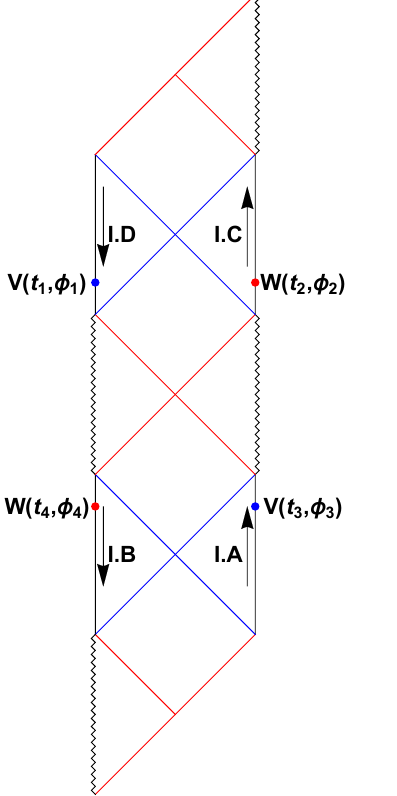
Figure 10 . The con(cid:12)guration of V and W operators in the rotating BTZ black hole spacetime. The arrows represent the direction of increasing Killing time t . To place the W operators in the shockwave limit, we must take t 2 = t 4 (cid:25) (cid:0) t for t large.